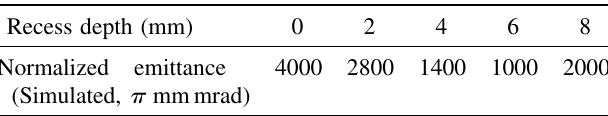
TABLE I. Normalized emittance relative to different